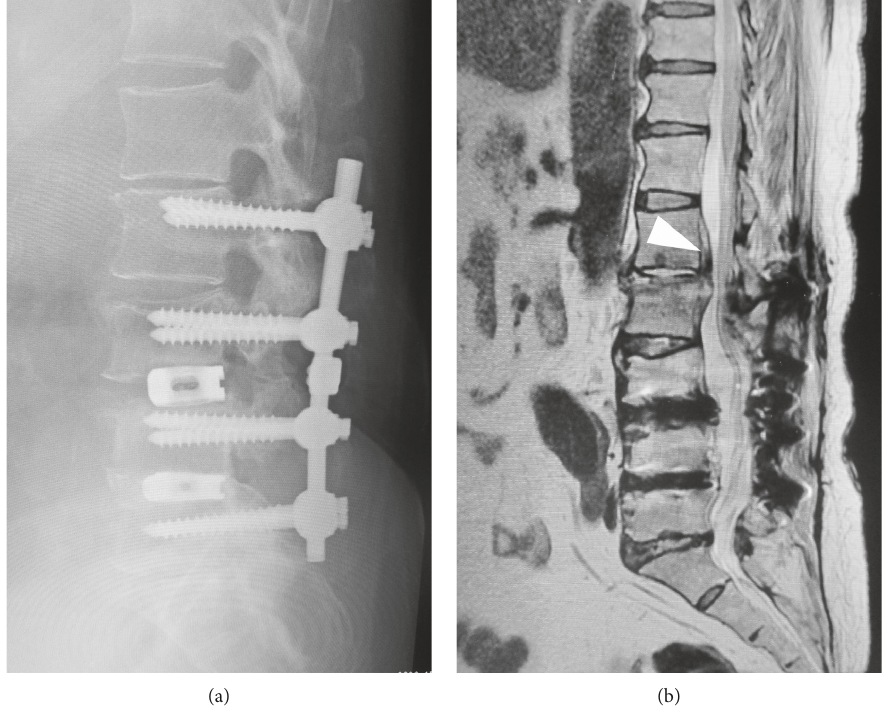
Figure 4: Case 2: plain lateral radiograph (a) and sagittal T2-weighted MRI (b) showed decreased disc height and the presence of an abscess in the disc and extradural space (arrowhead) at the L1-2